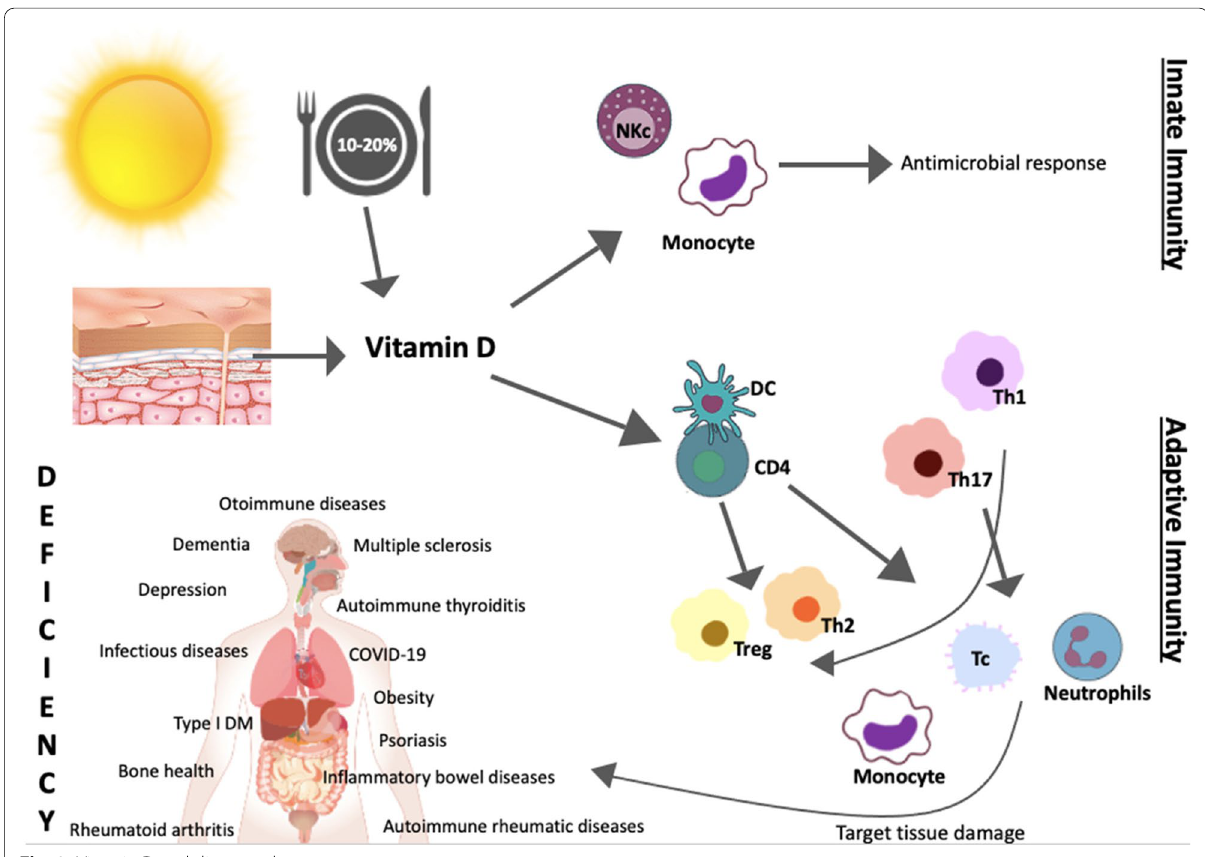
Fig. 2 Vitamin D and disease